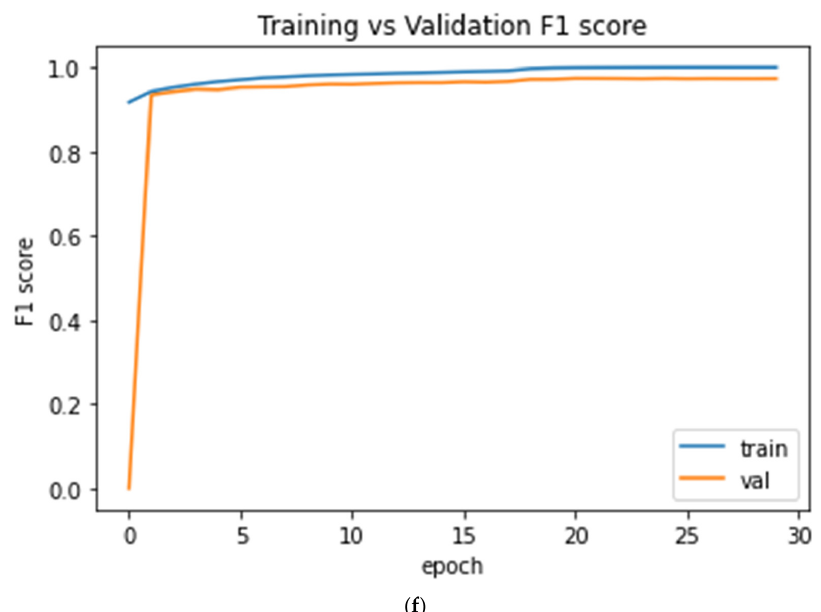
Figure 6. The evaluation score after 30 epochs training vs. validation plots; ( a ) Accuracy score curve; ( b ) IoU score curve; ( c ) dice_coeff score curve; ( d ) Precision score curve; ( e ) recall score curve; and ( f ) F1 score curve.